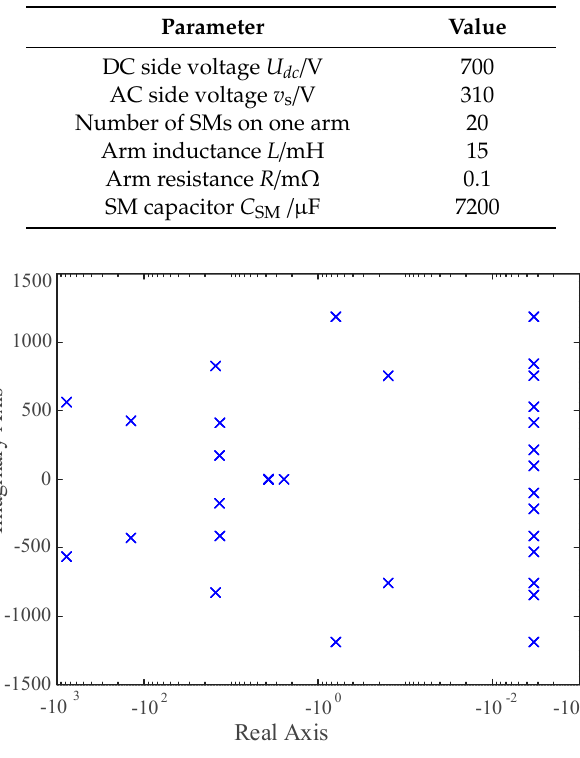
Table 1. The main parameters of MMC in calculation and simulation.